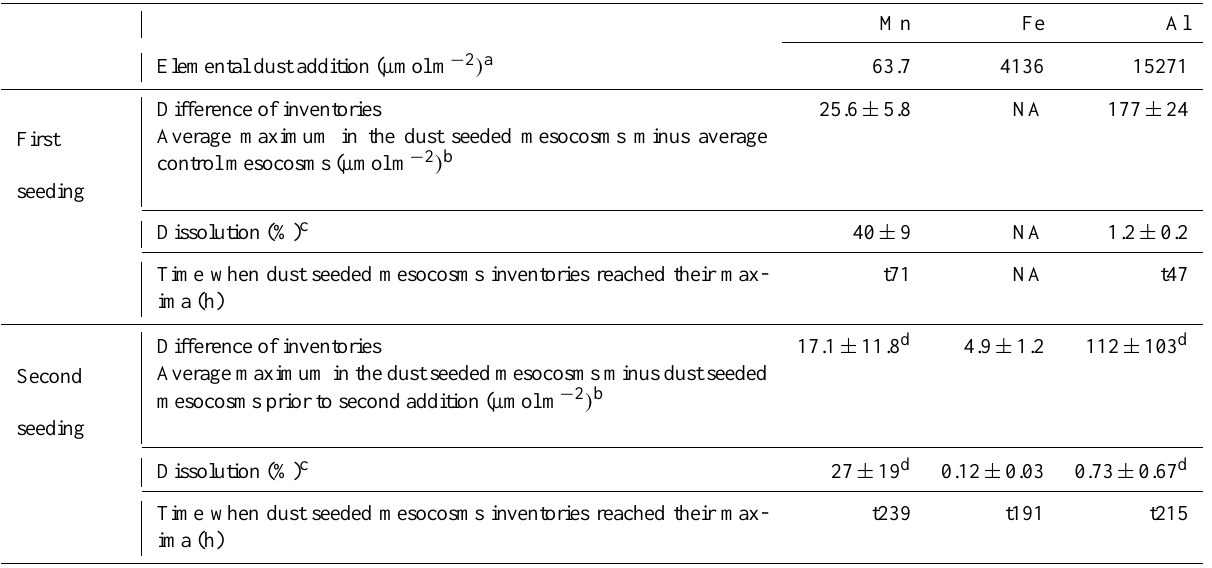
Table 2. Estimation of the elemental relative dissolution of dust in